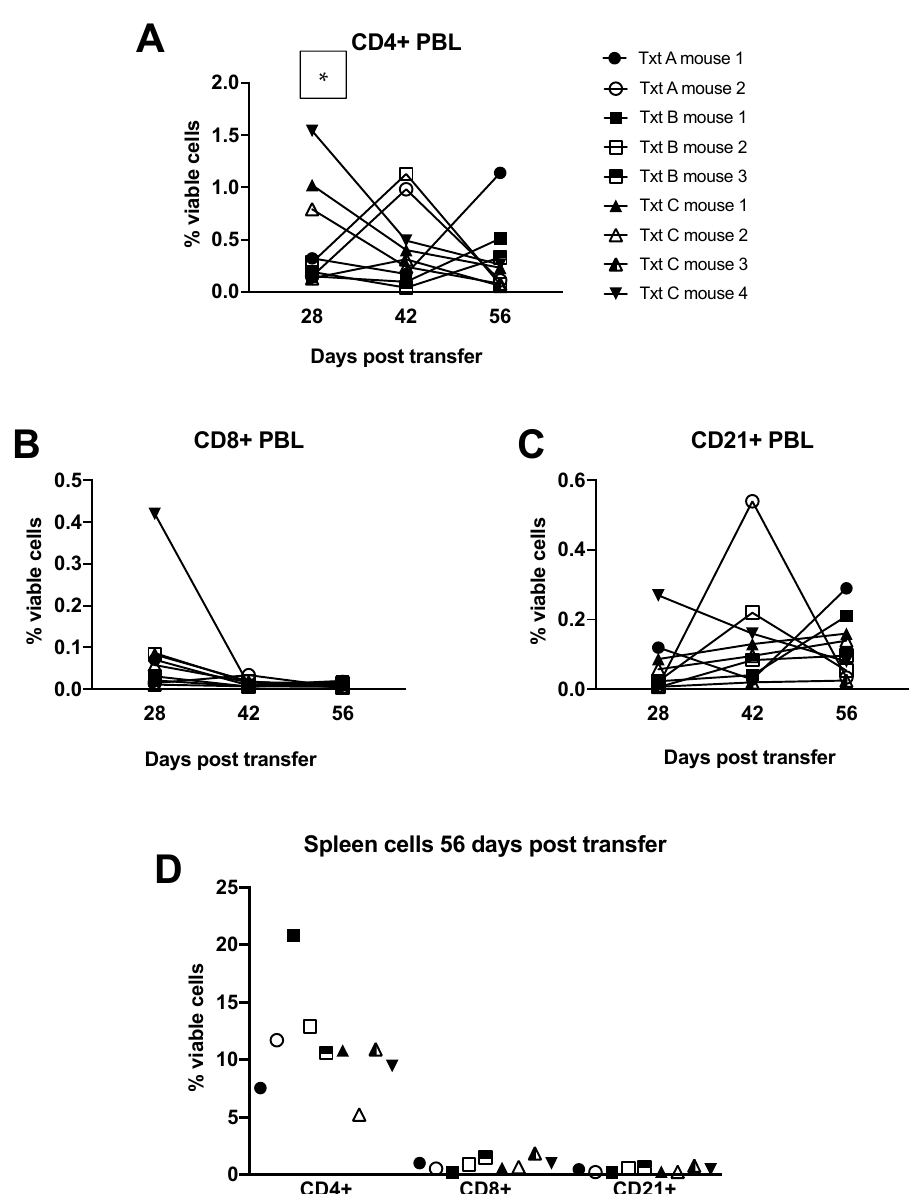
Figure 4. Equine bone marrow transfer into NSG hosts. ( A – C ) Percentages of equine CD4+, CD8+, CD21+ lymphocyte populations, respectively, in the peripheral blood of mouse recipients at day 28, 42 and 56 post-engraftment. ( D ) Percentages of equine CD4+, CD8+, CD21+ lymphocyte populations in the spleens of mouse recipients at 56 days post-engraftment. Txt = treatment. * p = 0.0285 using a paired, two-tailed t-test.